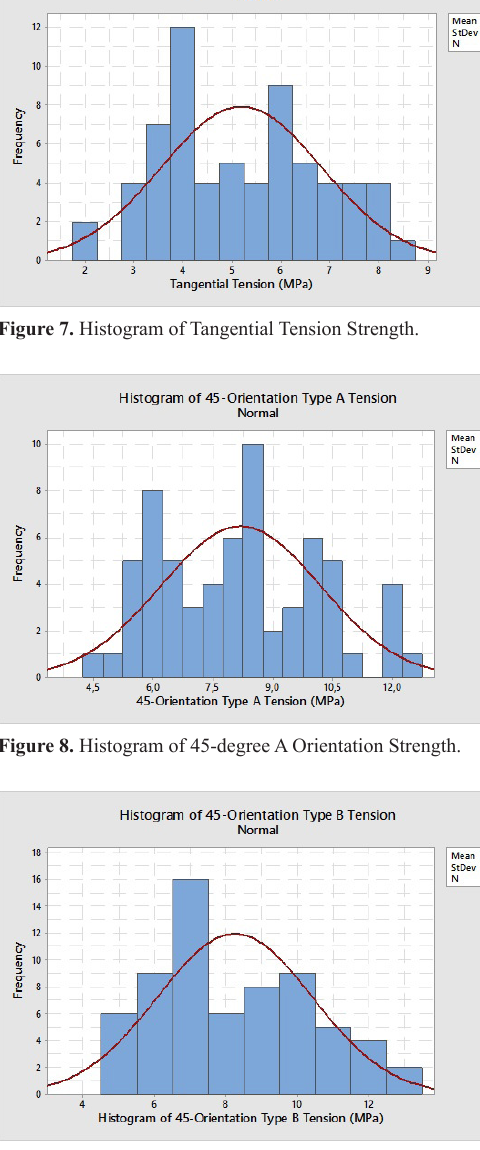
Figure 9. Histogram of 45-degree B Orientation